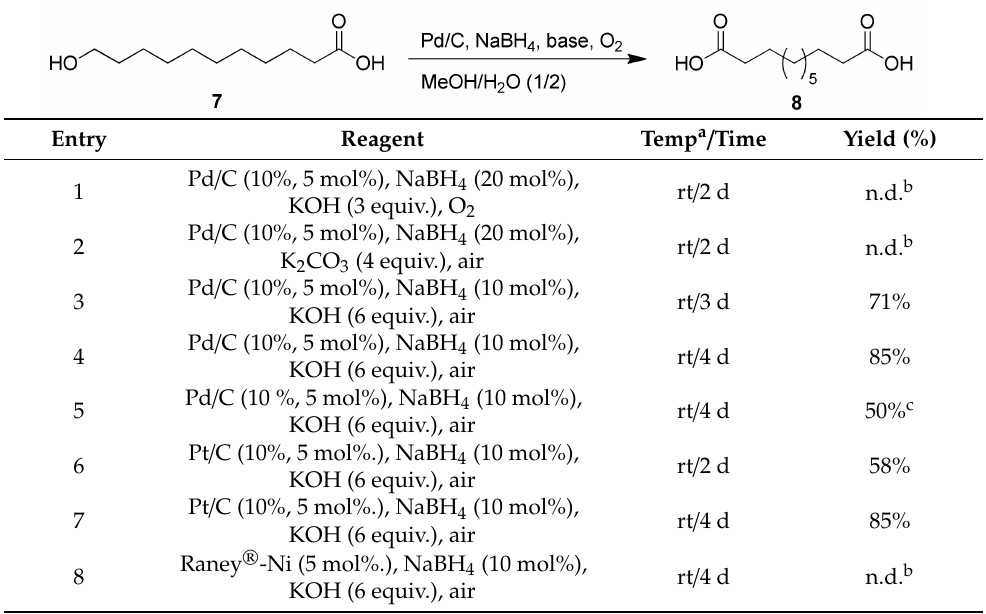
Table 1. Pd / C-catalyzed oxidation using NaBH 4 in basic aqueous